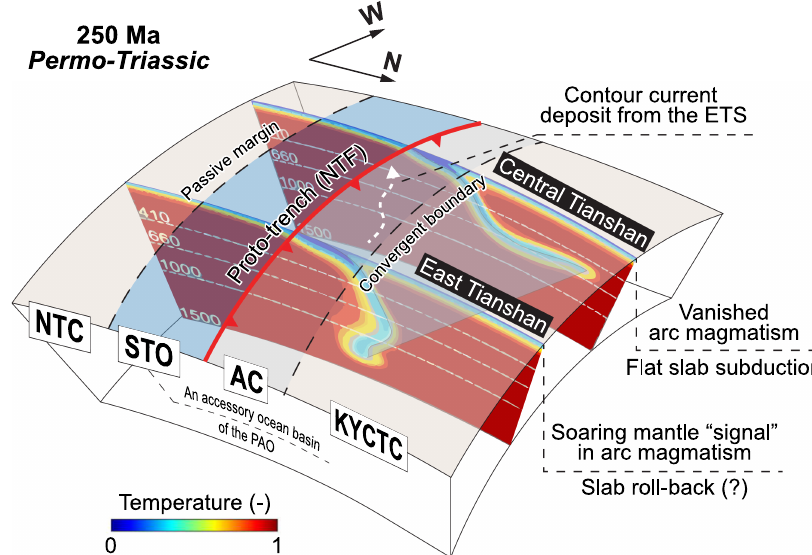
Fig. 8 An updated geodynamic model for the Permo-Triassic (~250 Ma) evolution of the South Tianshan Ocean (STO). The trench-paralleled slab geometry “ anisotropy ” (i.e., temporary fl at-slab subduction beneath the CTS region in the KYCTC), during which witnesses its fate from the Triassic to Permian, is highlighted. AC accretionary complex, KYCTC Kazakhstan-Yili-Central Tianshan Continent, NTC North Tarim Craton, NTF North Tarim Fault. The schematic diagrams of various slab geometry are cited from the results of numerical modeling by refs. 103,140 . Temperature is indicated by non- dimensional value, and T m = 1 is considered the dimensionless temperature of the